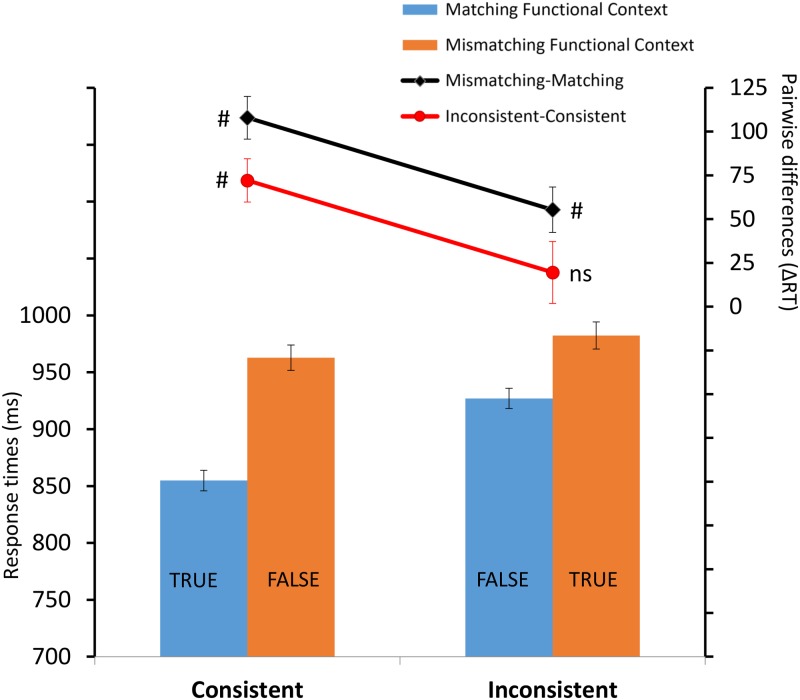
The bar plot shows the mean of response times as a function of X (consistent vs. inconsistent) and Y (matching functional context vs. mismatching functional context) factors. Error bars indicate within-subjects SEM (Morey, 2008). The black and red line plots show, respectively, the functional context effect (i.e., the mismatching functional context – matching functional context pairwise difference) in consistent and inconsistent conditions and the consistency effect (i.e., the inconsistent–consistent pairwise difference) in matching functional context and mismatching functional context conditions. The corresponding error bars indicate the SEM of the pairwise differences (Franz and Loftus, 2012). (#) indicates consistency and functional context effects that were significantly (p < 0.05) different from 0; (ns) indicates non-significant effects. TRUE and FALSE represent the two response options.